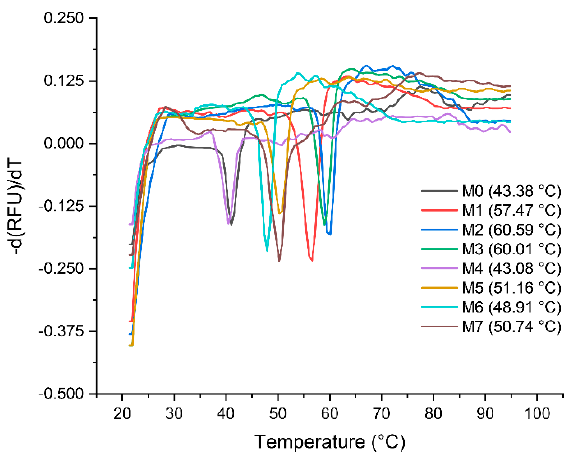
Figure 6. Analysis of stability of the VHHs. The values of T M were determined by melting curves via qPCR, and each value is average from five independent experiments.